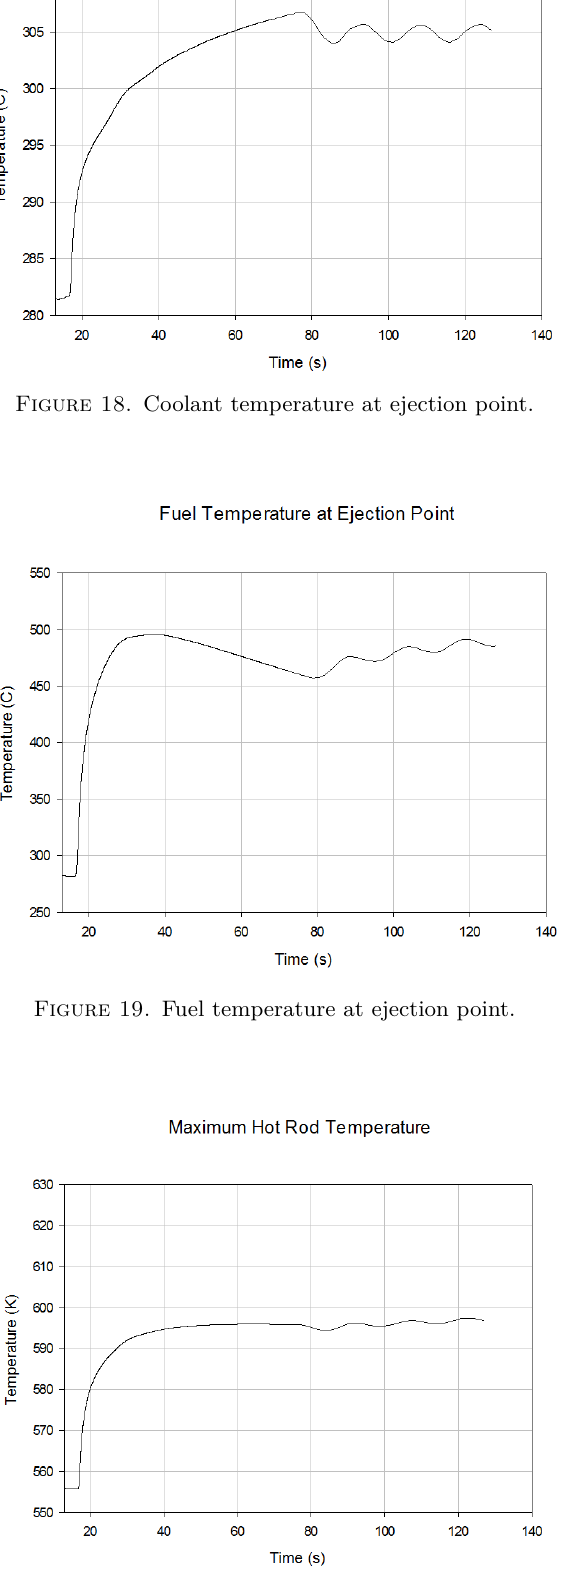
Figure 20. Maximal hot rod temperature.